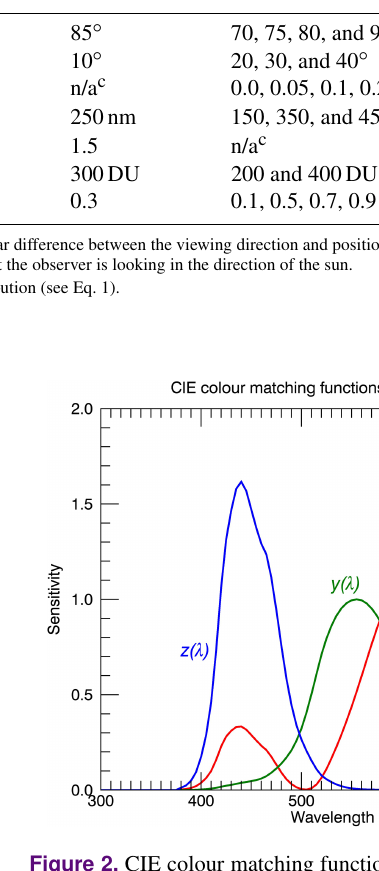
Figure 2. CIE colour matching functions of the human eye for the CIE 1931 2 ◦ standard observer, after Judd (1951) and Vos (1978) (http://cvrl.ioo.ucl.ac.uk/cmfs.htm, last access: 4 October